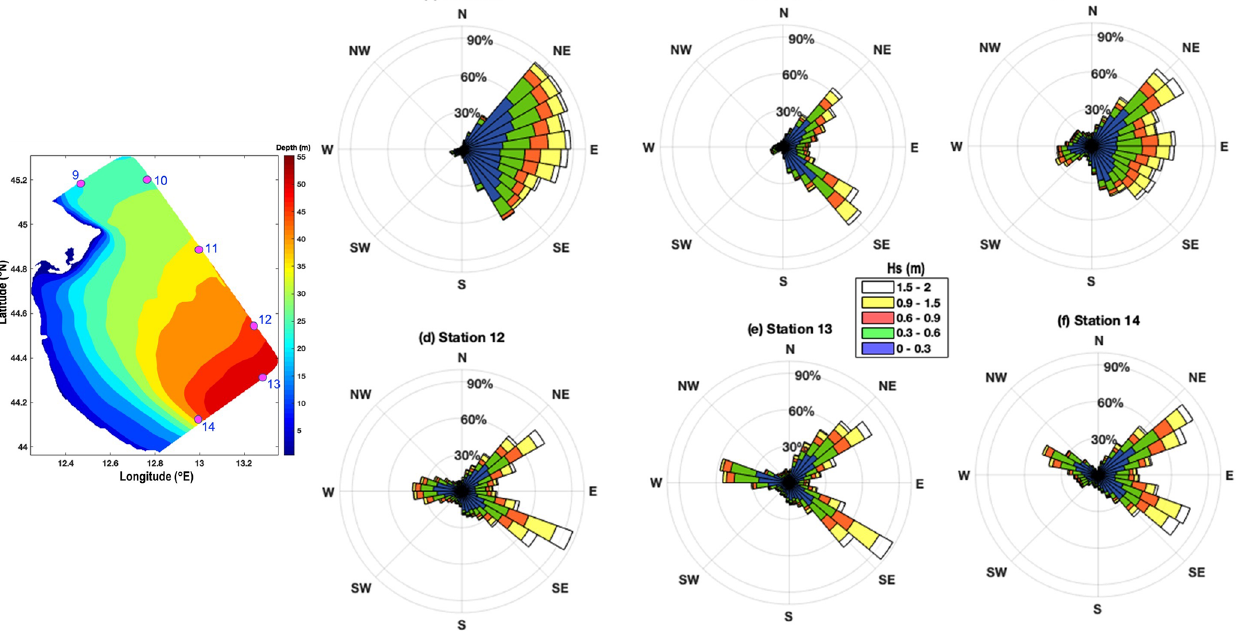
Figure 9. Offshore wave climate: wave rose diagrams in the boundaries of the model domain for the control points (9 to 14) as indicated in the location bathymetric map shown adjacently (left) (N: north; NE: northeast; E: east; SE: southeast; S: south; SW: southwest; W: west; NW: